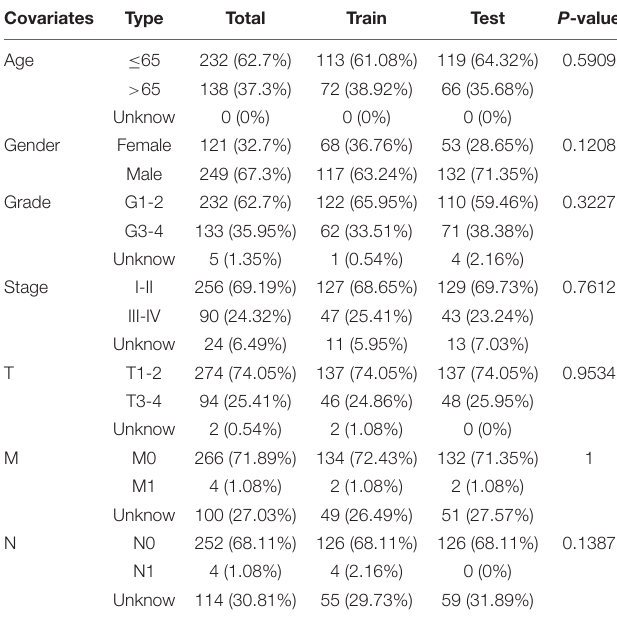
TABLE 1 | Clinicopathological parameters of hepatocellular carcinoma patients in training set, test set and TCGA data